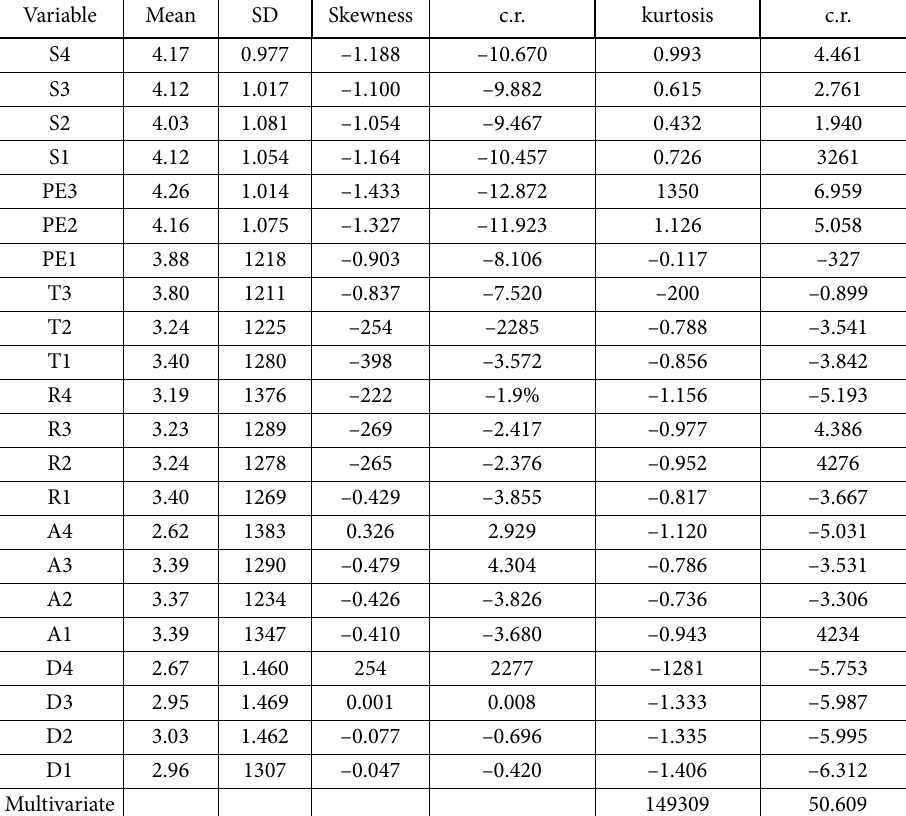
Table 4. Descriptive statistics and normality